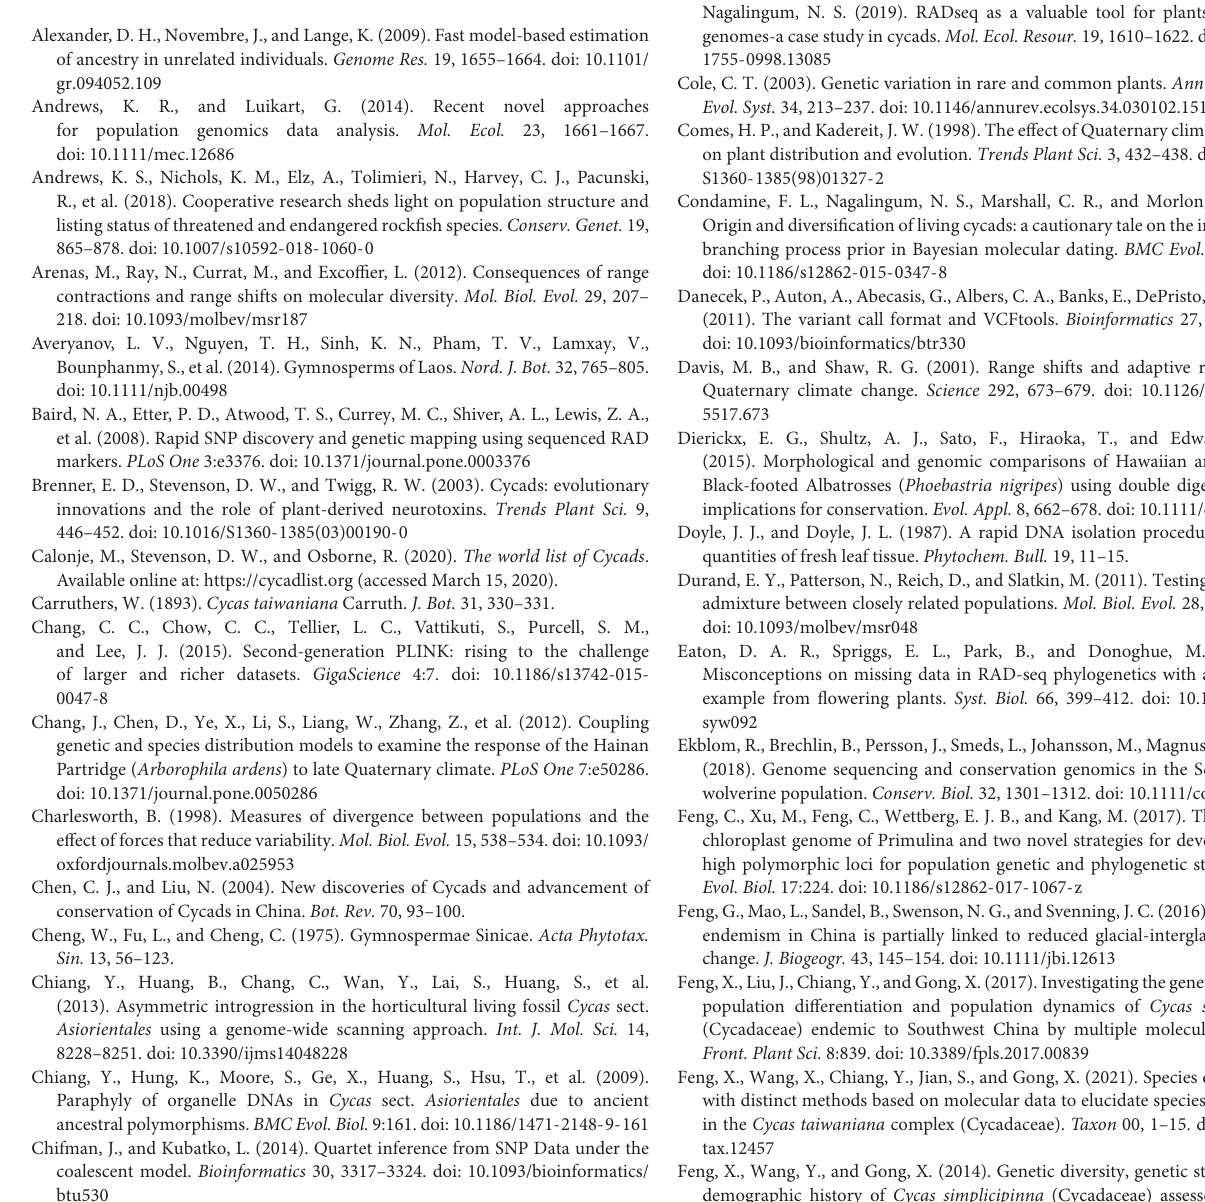
Supplementary Figure 3 | Species tree reconstructed using SVDquartets algorithm, with posterior probabilities given at each node. Supplementary Figure 4 | Results from A DMIXTURE with K = 4 based on genome-wide SNP data. Supplementary Table 1 | Sampling information for each sample of the six studied Cycas species. Supplementary Table 2 | Number of SNPs generated with a series of parameter combinations ( m , M , and n ) during preliminary analysis with S TACKS . Supplementary Table 3 | Sequence characteristics of RADseq for each sample of the six Cycas